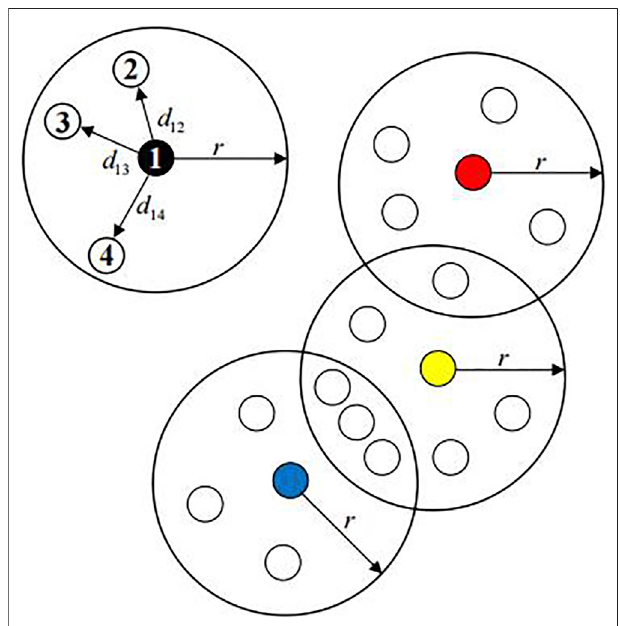
FIGURE 1 | Dissimilarity density ρ